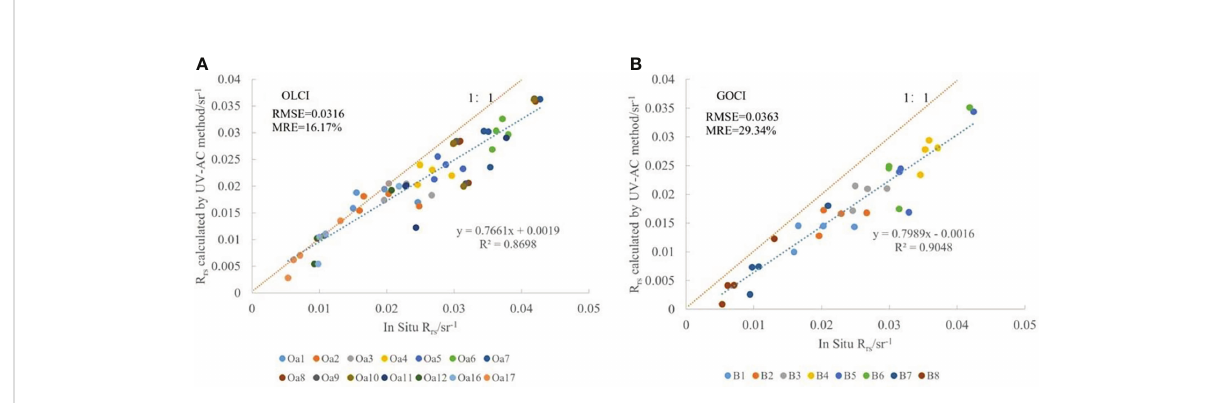
FIGURE 3 Scatter validation of atmospheric correction accuracy based on OLCI (A) and GOCI (B)